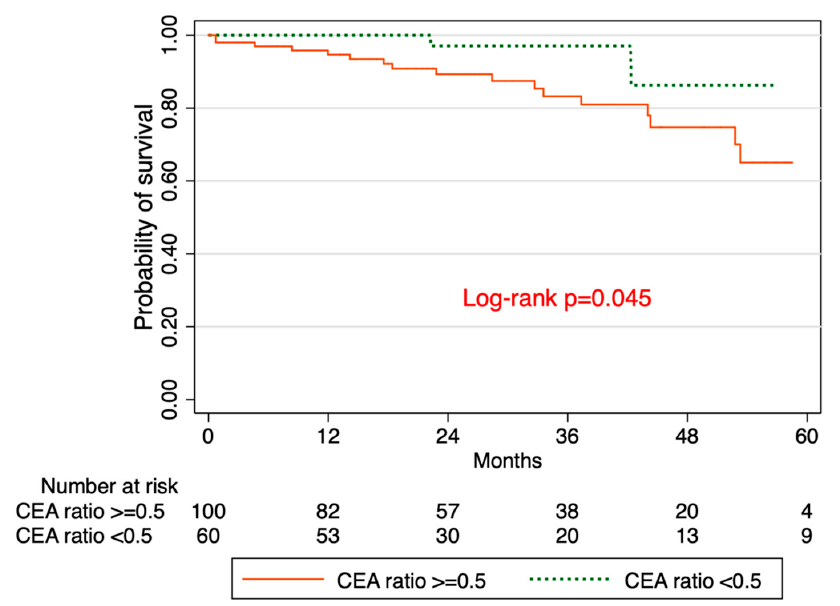
Figure 1. Kaplan–Meier survival based on carcinoembryonic antigen (CEA) ratio.